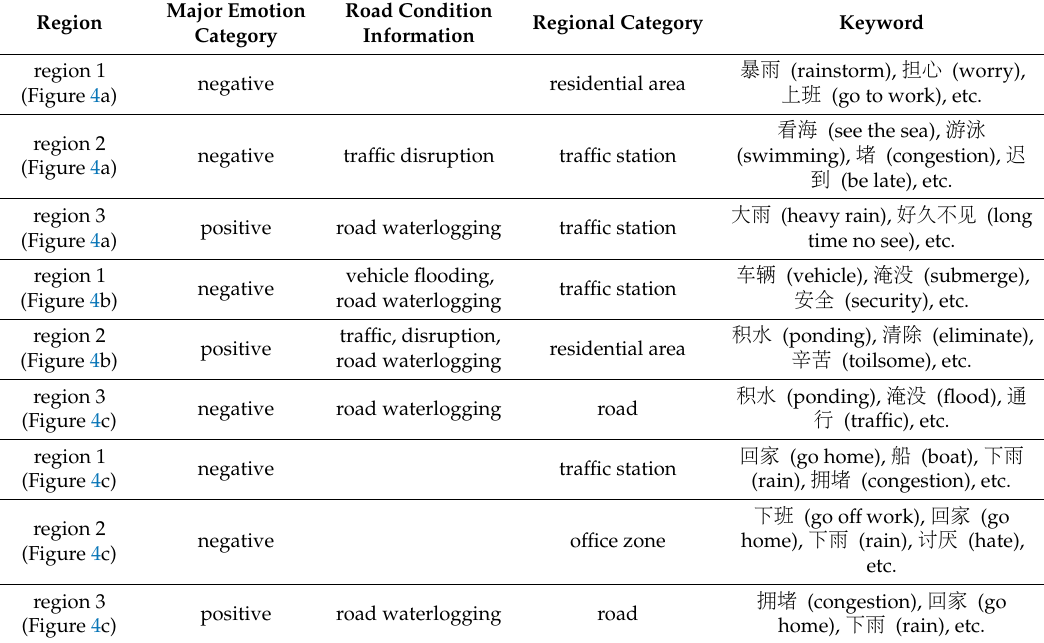
Table 4. Disaster characteristics in di ff erent regions and in di ff erent time